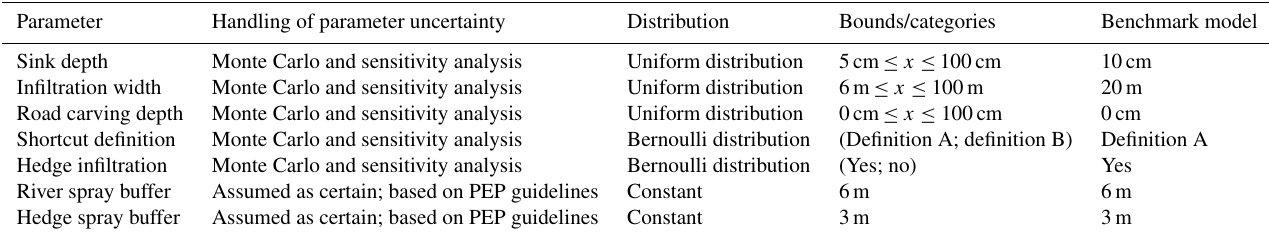
Table 2. Summary of parameter distributions used for the Monte Carlo analysis and parameter values used as a benchmark for the sensitivity analysis. PEP – Swiss proof of ecological